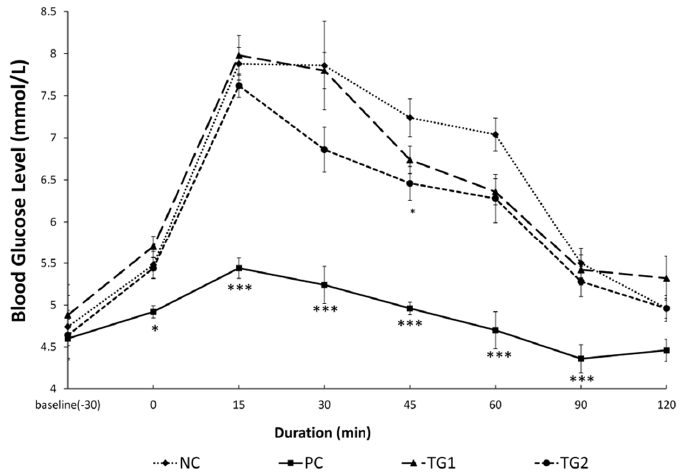
Figure 1. Oral Glucose Tolerance Test with Gongronema latifolium extract in normal rats ( n = 5). Values are expressed as the mean ± SEM, * = p < 0.05; *** = p < 0.001 vs. NC.